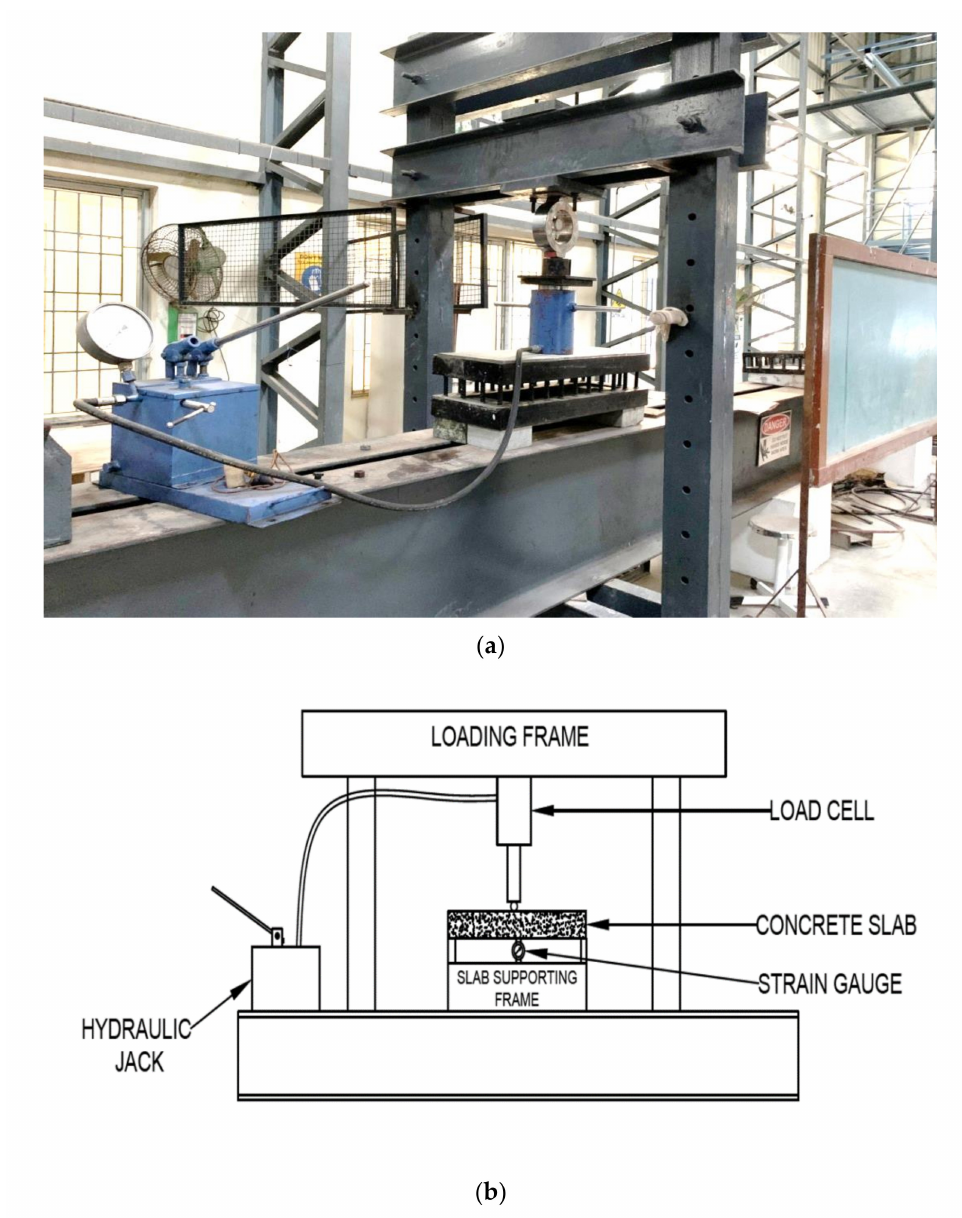
Figure 5. ( a ) Experimental setup for repeated loading; ( b ) schematic representation of loading